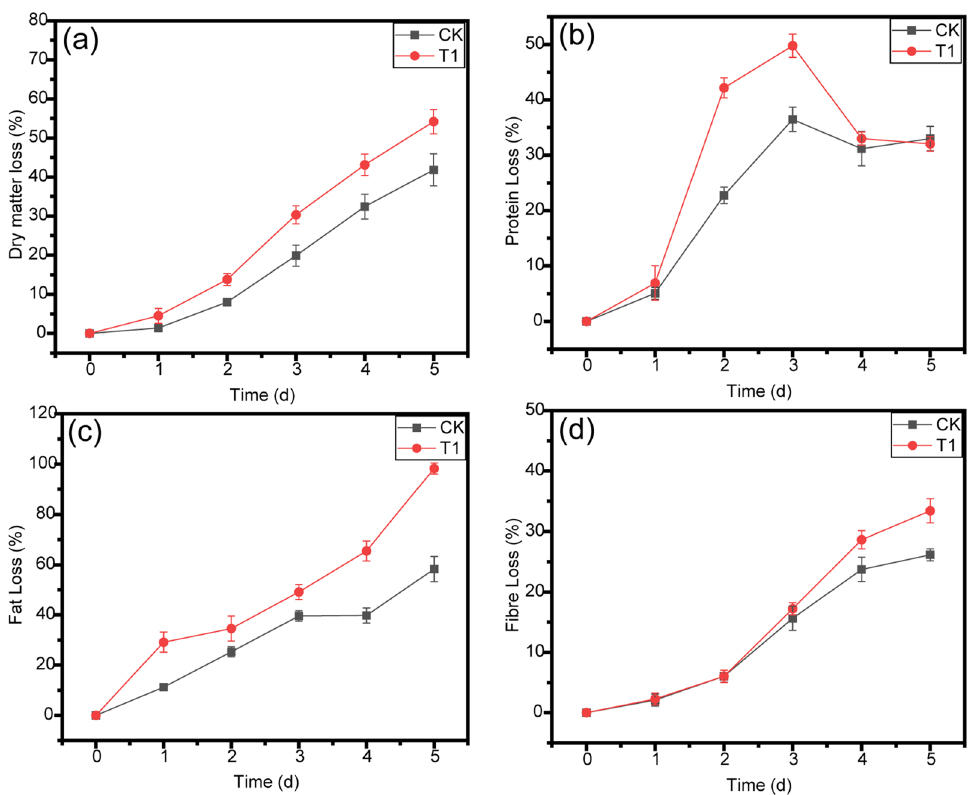
Figure 5. Profiles of dry matter loss (a) , protein loss (b) , fat loss (c) and fibre loss (d) in CK and T1 during fermentation process. The data represent the means ± standard deviations from three